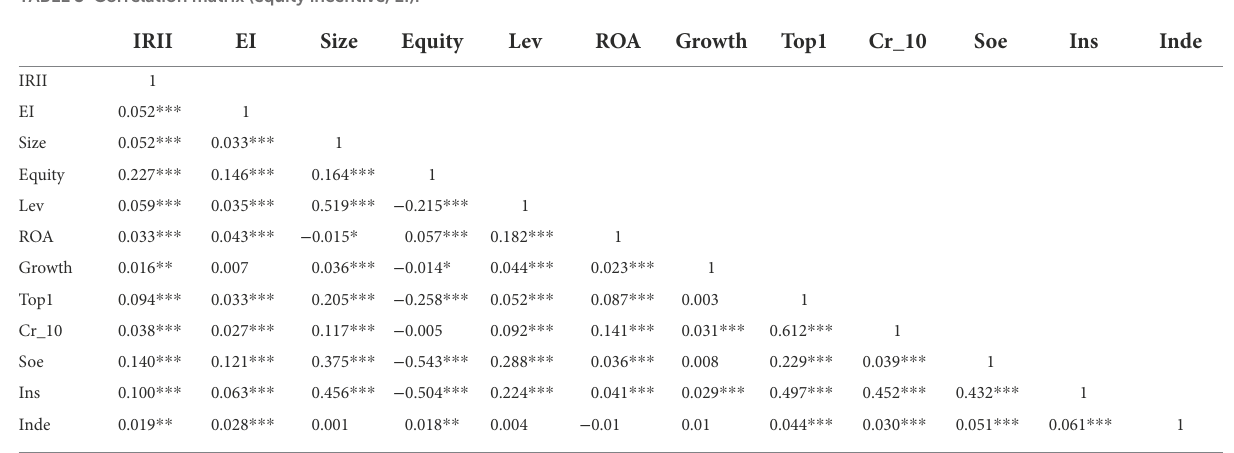
TABLE 3 Correlation matrix (equity incentive,